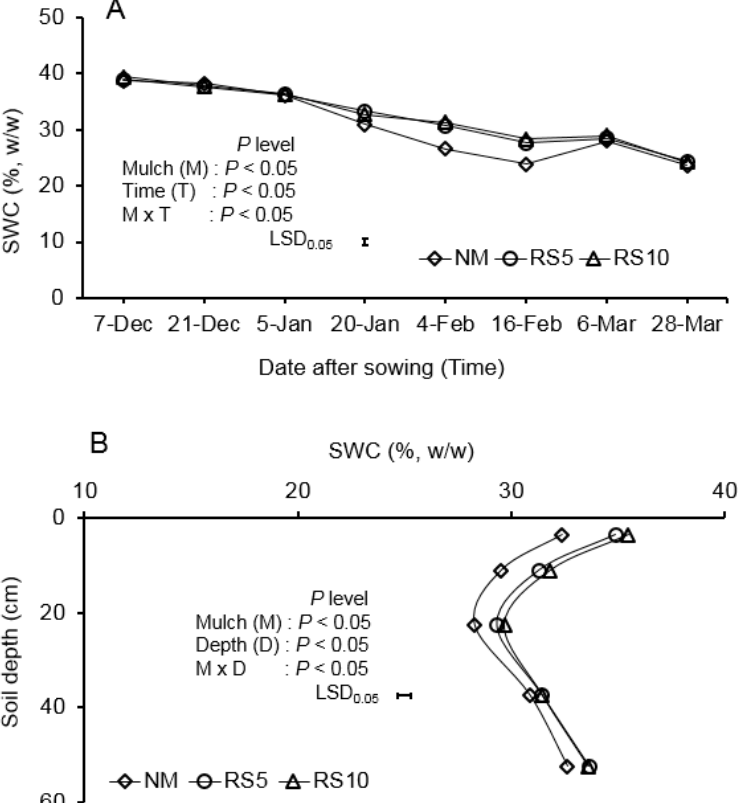
Figure 3. Effects mulch on soil water content (SWC) in the 2018–2019 season: ( A ) effect of mulch and the interaction between mulch and time and ( B ) interaction between mulch and soil depth. LSD 0.05 is the least significant difference of the interaction between mulch and time ( A ) or mulch and soil depth ( B ). Part A is the average for the five soil depths. Part B is the average of values at eight times. NM = no-mulch; RS5 = rice straw at ~5 t ha − 1 ; RS10 = rice straw at ~10 t ha − 1 .